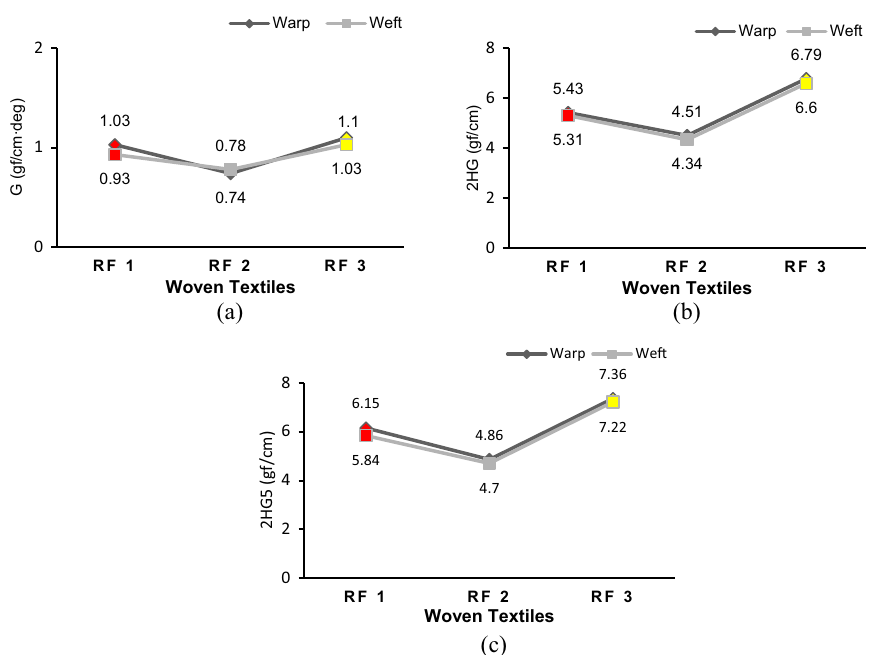
Fig. 12 a Shearing rigidity (G—gf/cm deg.), b hysteresis of shear force at 0.5° (2HG—gf/cm) and c hysteresis · of shear force at 5° (2HG5—gf/cm). RF Reflective